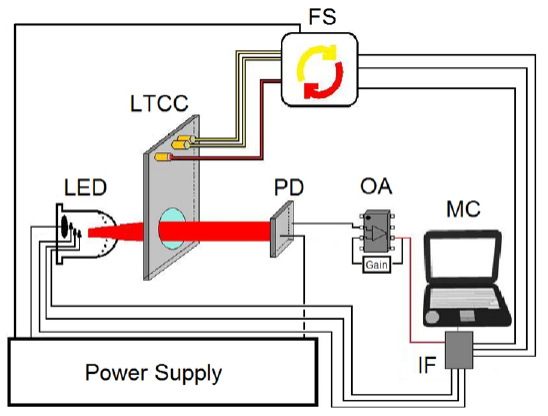
Figure 3. RGB-LED photometer and LTCC-FA. The system consists of a peristaltic pump, solenoid valves, tubes, and SPR; PD; OA - operational amplifier; MC - microcomputer; and IF -